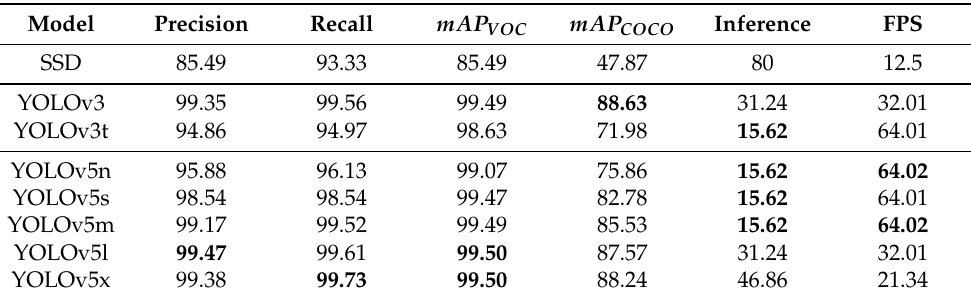
Table 1. Results of the models over the test set, where mAP VOC is the PASCAL VOC metric and mAP COCO corresponds with the COCO metric. Inference time is measured in ms, and YOLOv3t is YOLOv3-tiny. Best results are highlighted in